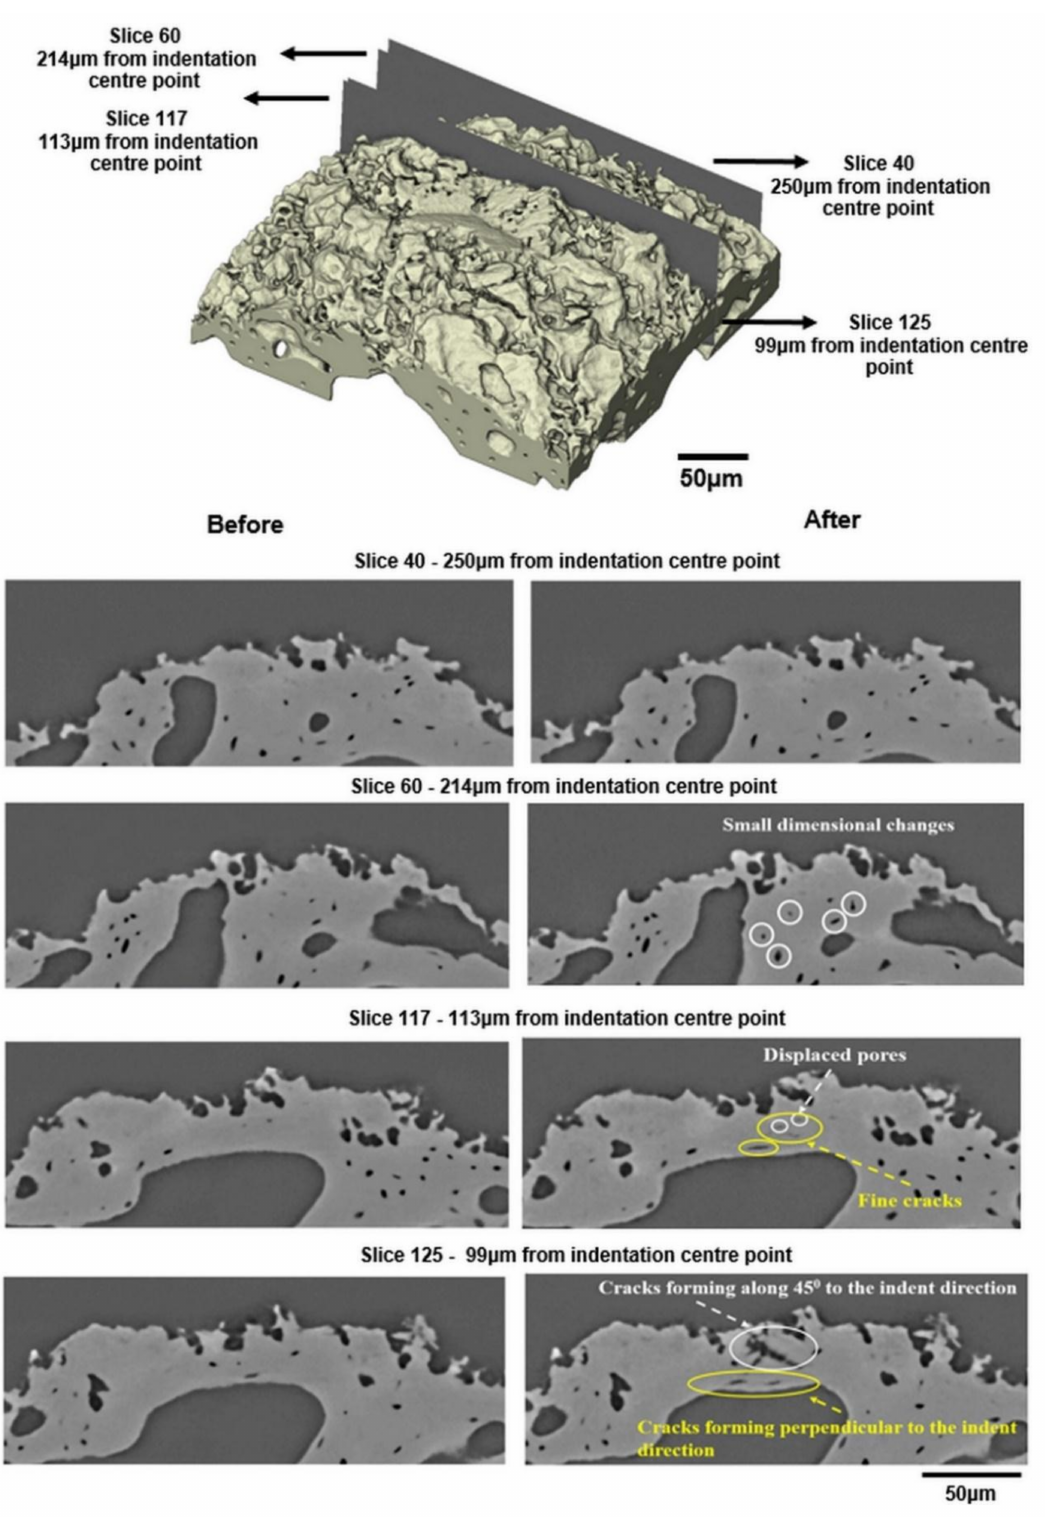
Figure 8. Individual virtual slices before ( left ) and after ( right ) indentation at distances of 250 µ m, 214 µ m, 113 µ m and 99 µ m from the indenter tip (see also animated sequences in supplementary video